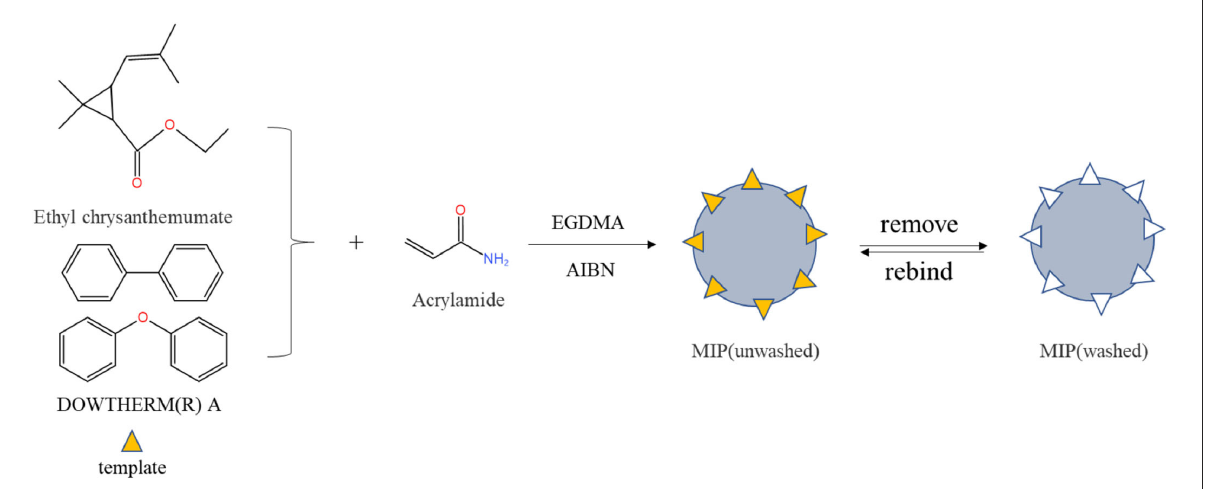
FIGURE1 The synthesis process of